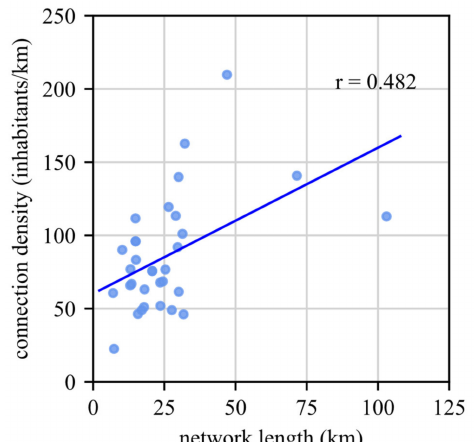
Figure 1. Correlation between total network length and connected inhabitants for the investigated